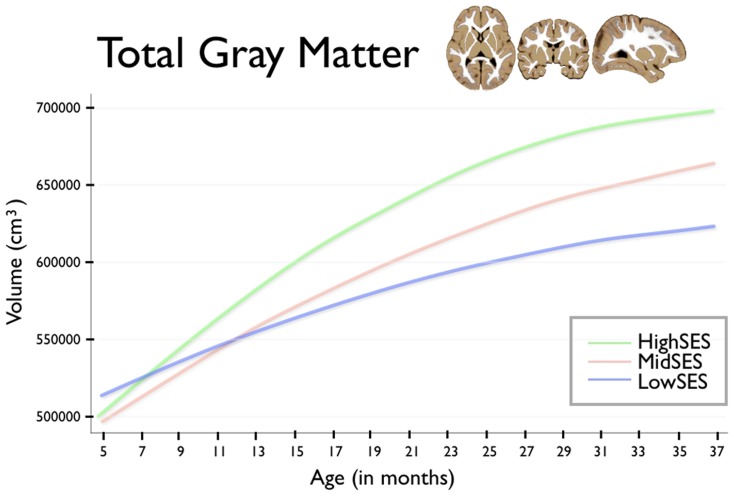
This figure shows total gray matter volume for group by age.Age in months is shown on the horizontal axis, spanning from 5 to 37 months. Total gray matter volume is shown on the vertical axis. The blue line shows children from Low SES households; children from Mid SES households are shown in red. The green line shows children from High SES households.